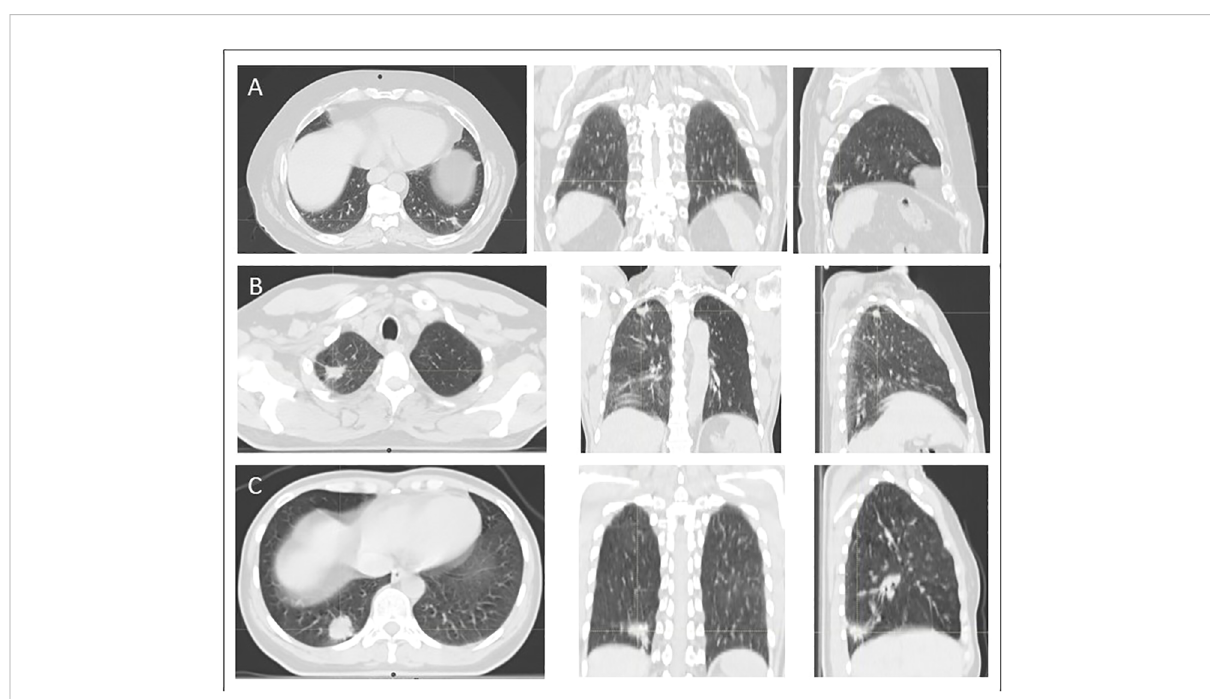
FIGURE 1 Illustration of peripheral localization of tumors included in this study. In case (A) , 66-year old man with a peripherally located advanced adenocarcinoma NSCLC stage III in the left lower lobe is demonstrated. Case (B) shows a 53-year old man with a peripherally located advanced squamous